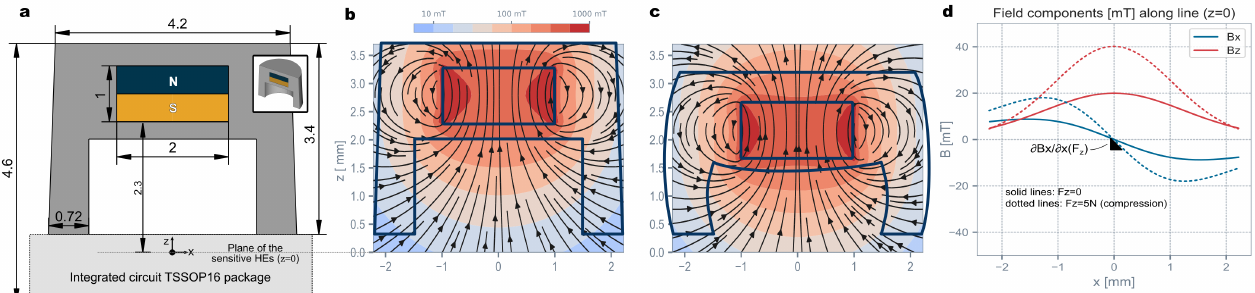
Figure 2. ( a ) XZ cross-section of the elastomer with the embedded magnet above the air cavity. Note that the sensor is centered on the origin, and the sensitive Hall elements (HEs) are on the z = 0 plane. ( b , c ) Magnetic field lines at rest and under compression ( F z ≈ 5N, based on the design estimation). ( d ) Magnetic field components along the X axis.